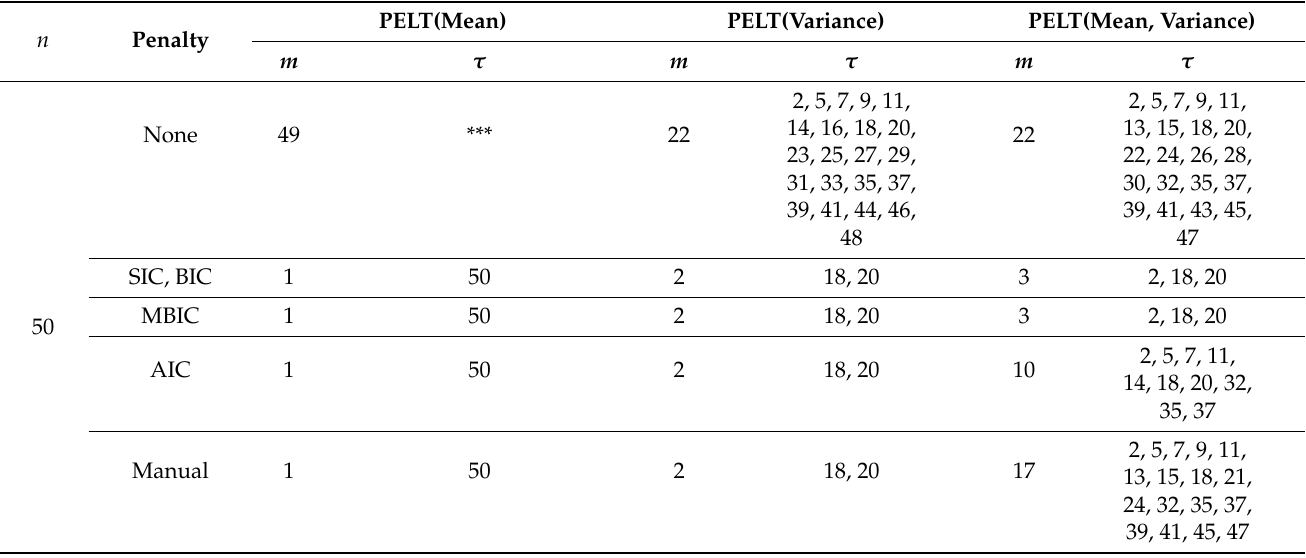
Table A2. PELT Algorithm Result for Simulated Transmissibility